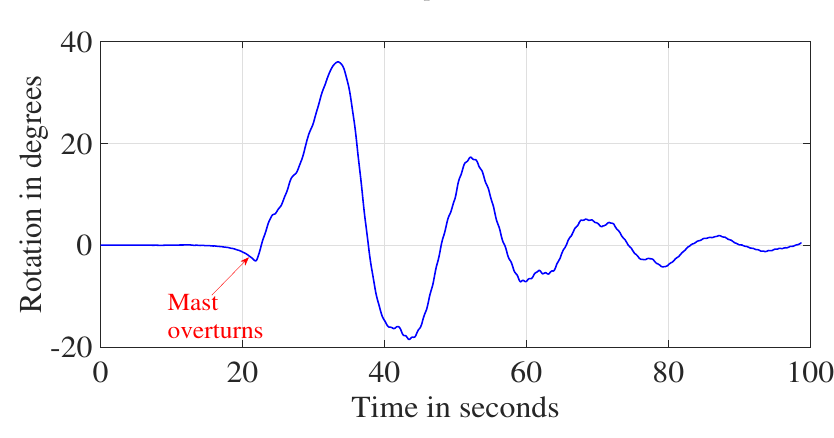
( b ) Rotation time history of the tower at rotor level.